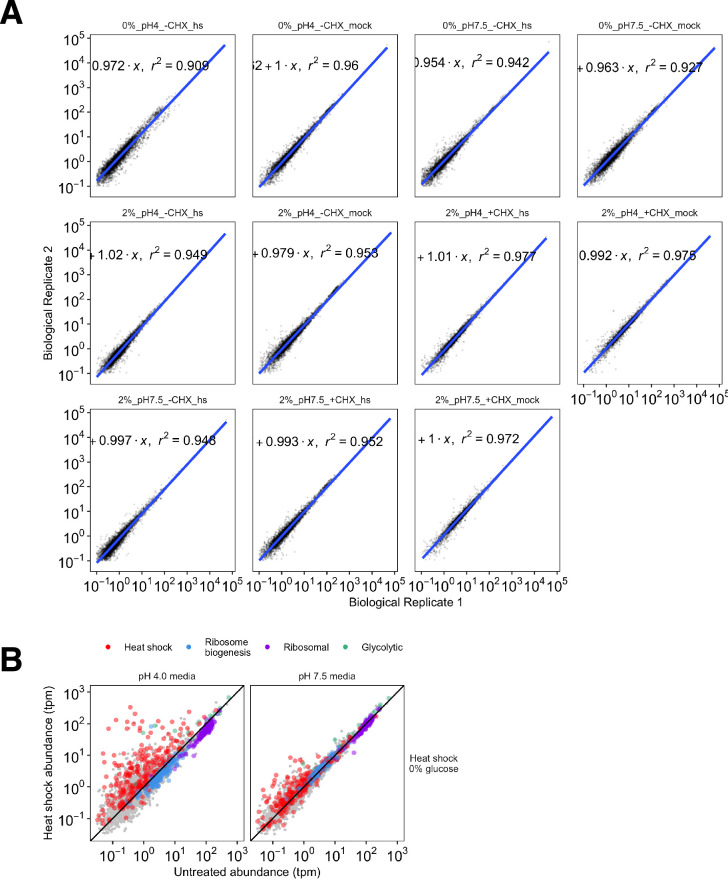
Variation between replicates and induction of heat shock genes after brief acute glucose withdrawal.(A) Correlation between gene abundances in replicate samples (RNA-seq data) (B) Gene abundances in cells heat shocked after acute glucose withdrawal – unstressed abundances are shown on the x-axis, abundances after stress on the y. Color corresponds to gene type.